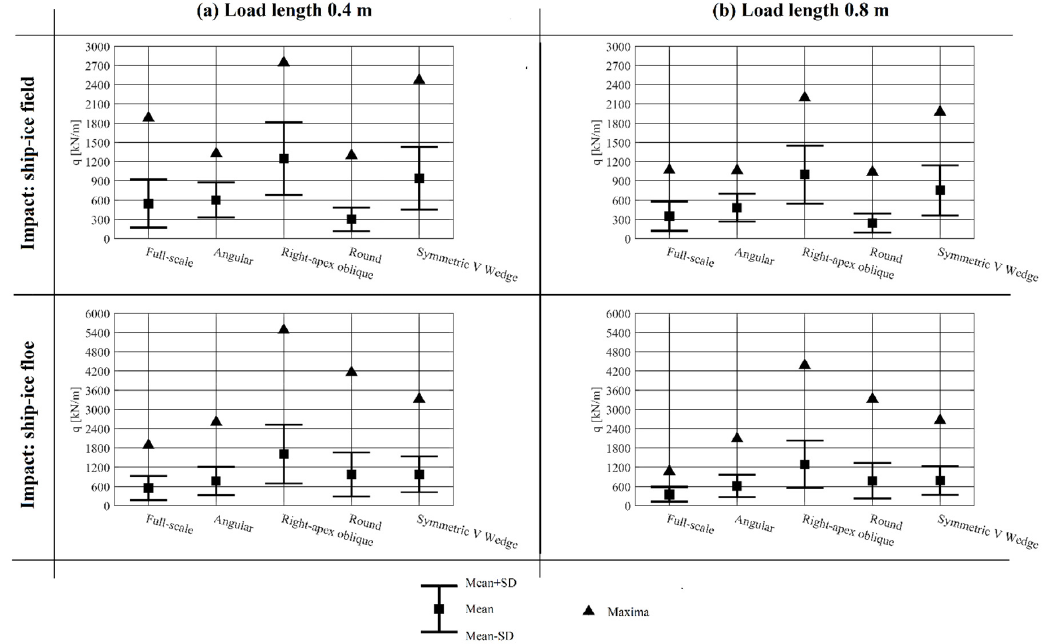
Figure 6. Comparison between loads calculated for different collision scenario assumptions with corresponding full-scale measurements in terms of 10-min mean, standard deviation (SD) and maximum. Load length 0.4 𝑚 corresponds to loads on one frame spacing (frame 134), whereas load length 0.8 𝑚 corresponds to loads on two frame spacing (frame 134 + 134.5).